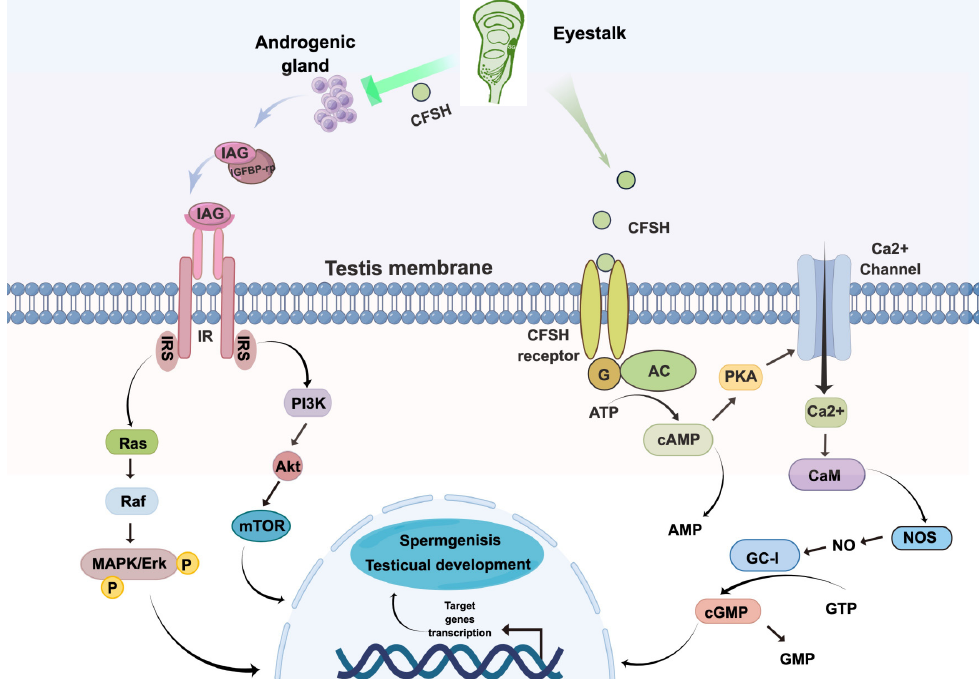
Figure 8. Hypothetical pathway for the mode of the CFSH action in P. trituberculatus . There may be different pathways for CFSH. One is acting on the testis through the classical insulin pathway and the other is acting directly as a neuropeptide to complete the signal transduction. IAG: insulin-like androgenic gland hormone; IGFBP-rp: insulin growth factor binding protein-related protein; IR: in- sulin-like hormone receptor; IRS: Insulin receptor substrate; G: G protein; AC: activation of adenylyl cyclase; GC-I: NO-sensitive guanylyl cyclase.